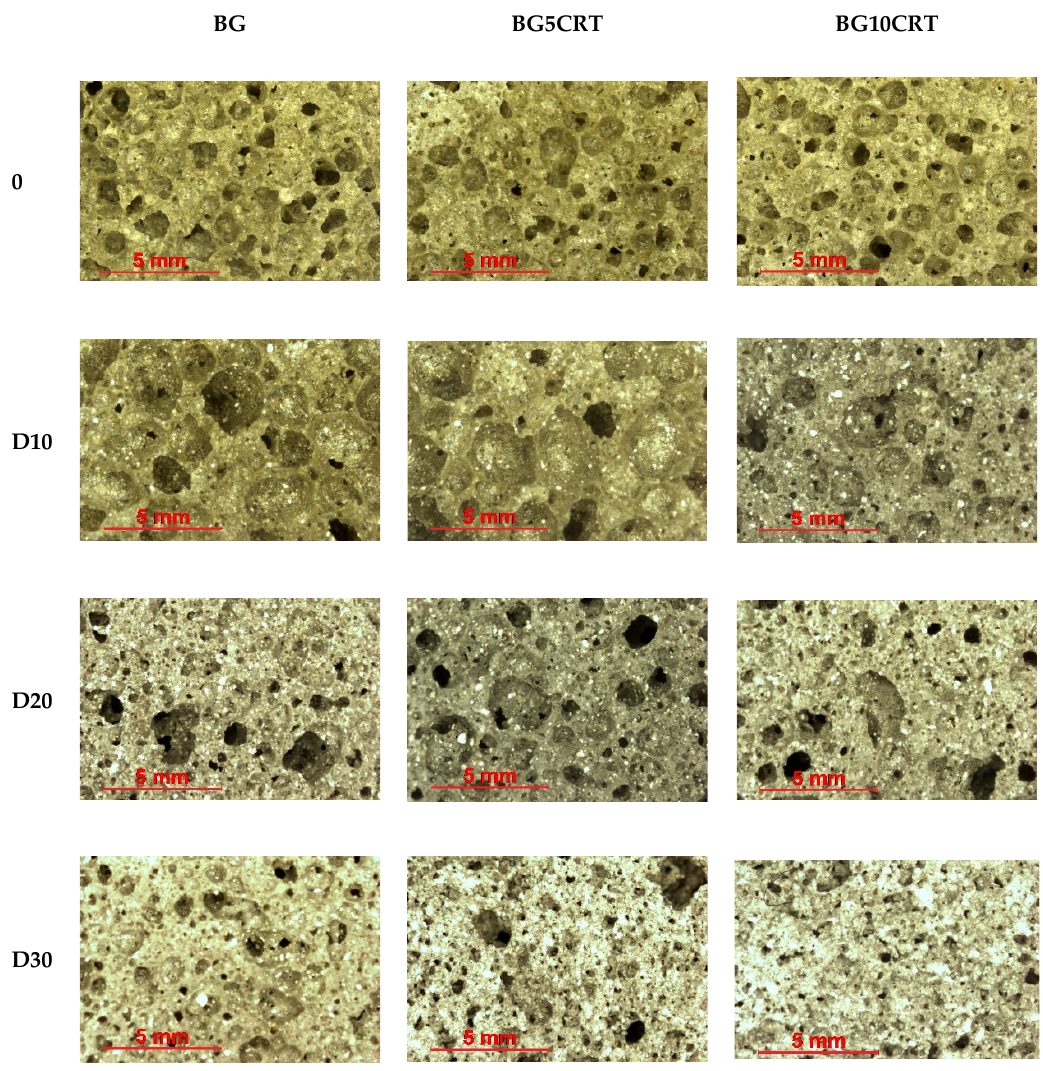
Figure 5. Microstructure of the foam glasses (scale bar = 5 mm).